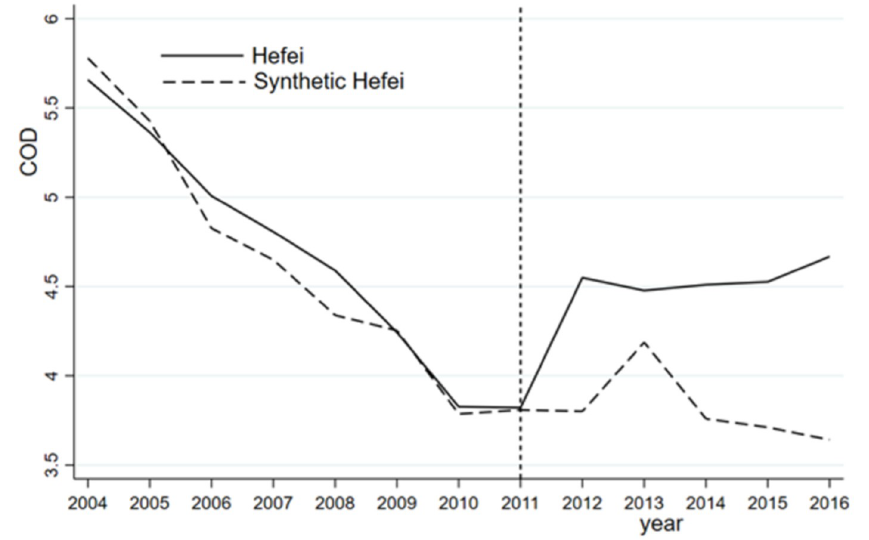
Fig 4. COD of Hefei and synthetic Hefei (excluding Beijing, Shanghai, and Tianjin).